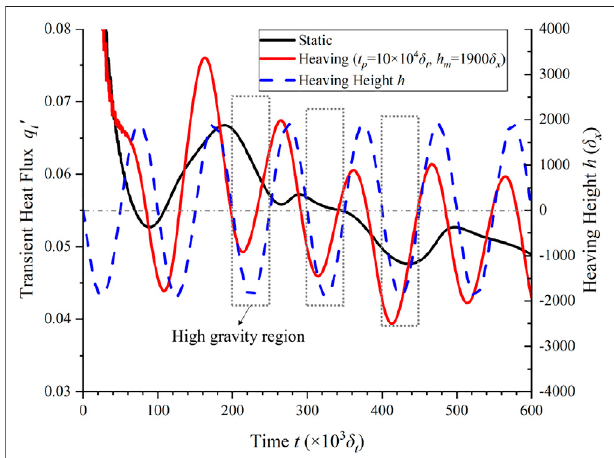
FIGURE8| Transientheat fl uxattheconvectionregimewithJa (cid:1)